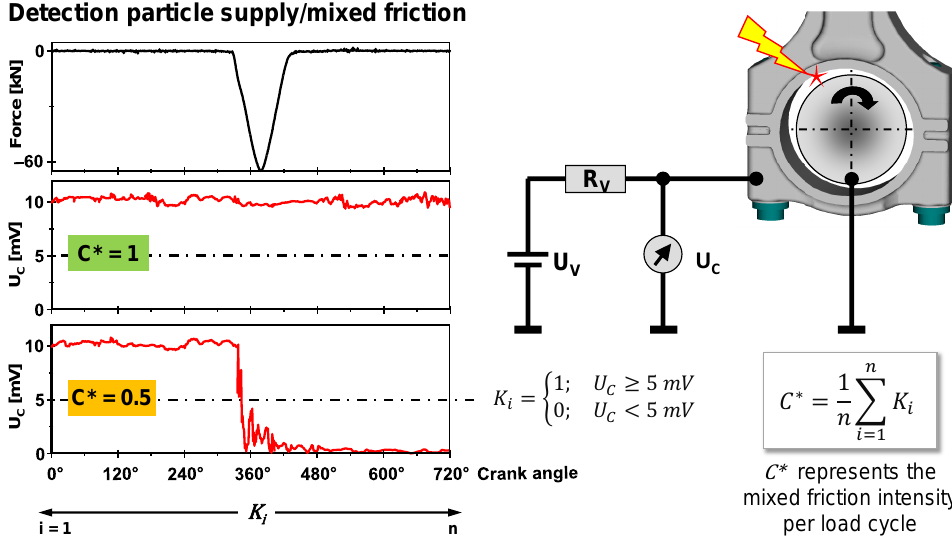
Figure 13. Definition of mixed friction coefficient and schematical drawing of the contact detection